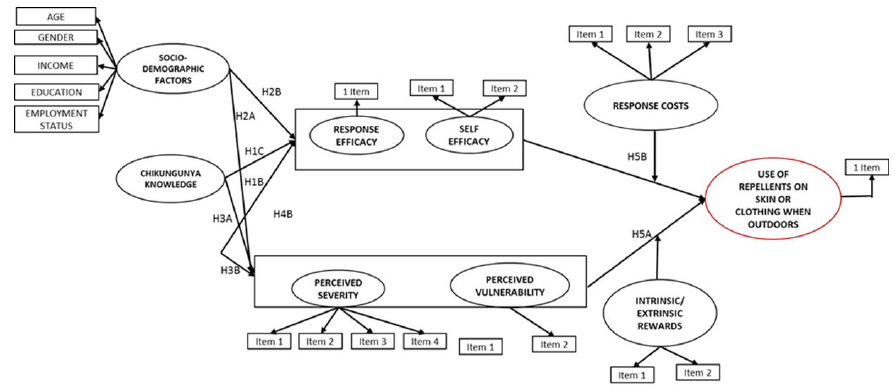
Figure 1. Conceptual Framework for the hypothesized Relationships Between Predictor Variables and Use of Insect Repellents Among US Travelers to Caribbean